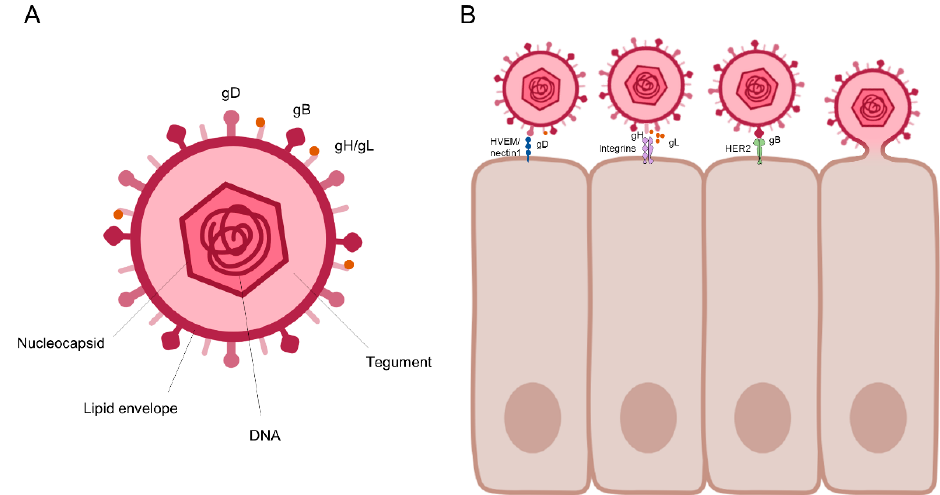
Figure 1. The structure of HSV and its entry ( A ) HSV virus structure. HSV has several glycoproteins in its lipid envelope, including glycoproteins, gD, gB, and gH / gL, which are known to function in cell entry. gB and gD are the most targeted molecules in the development of a vaccine against genital herpes. gB is targeted for CD4 T cell activation and gD is targeted for CD8 T cell activation. ( B ) HSV cell entry. First, gD binds to HVEM / nectin1, and this binding signals gL dissociation from gH. The gH-integrin interaction then leads to gB-HER2 binding. These serial binding interactions lead to HSV entry into the host cell. Images are created with BioRender.com.